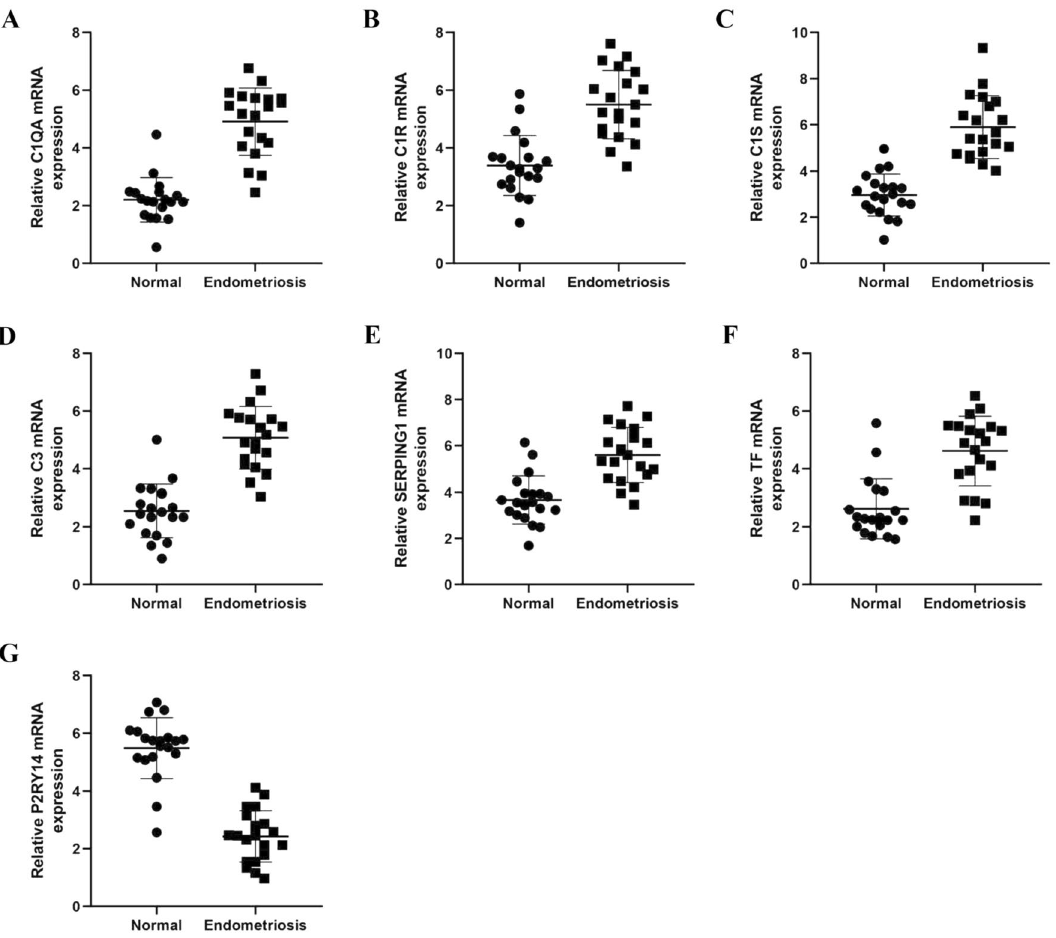
Figure 6. The mRNA expression of hub genes between groups by qPCR. ( A – E ) the expression of SERPING1, C1S, C1QA, C1R, and C3 were frequently up-regulated in the EMs group compared with the normal group. ( F